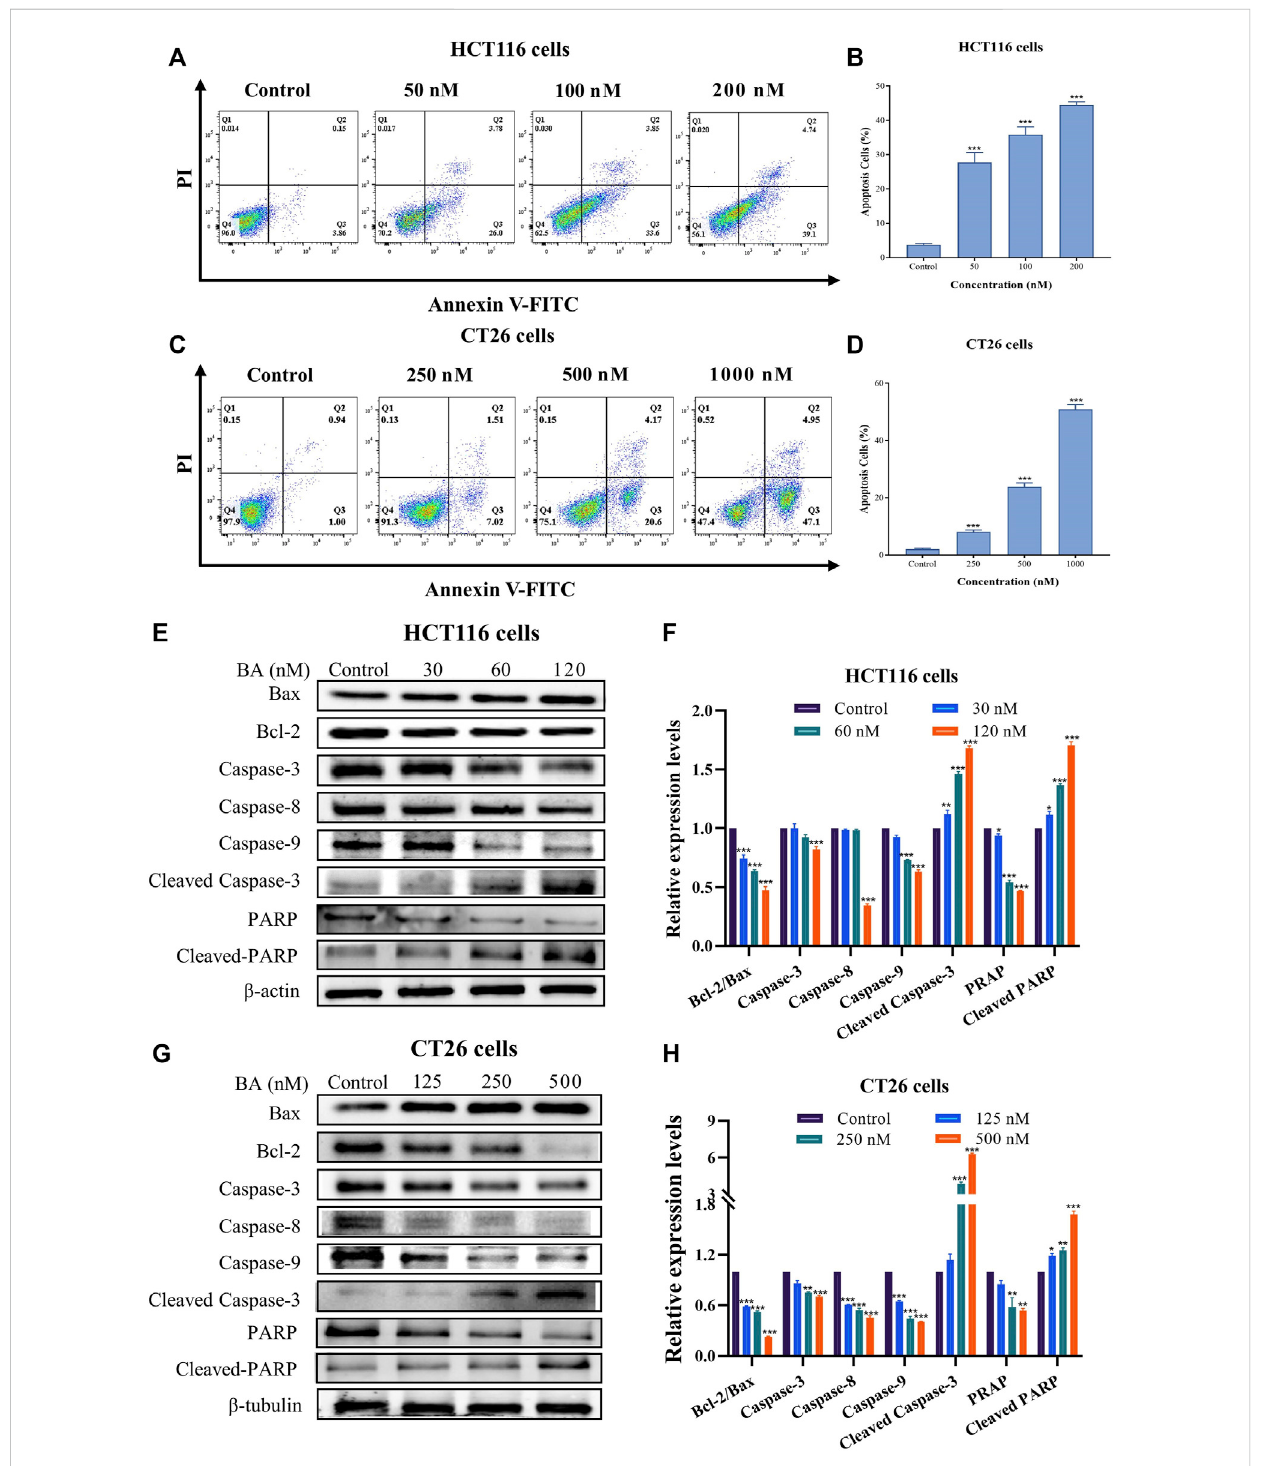
FIGURE 5 BA induced cell apoptosis in HCT116 and CT26 cells. (A – D) The level of apoptosis of HCT116 (A) and CT26 (C) cells treated with BA was assessed by Annexin V-FITC/PI double staining. Statistical analysis of the apoptosis rate of HCT116 (B) and CT26 (D) cells treated with BA. (E – H) The protein expression levelsofBax,Bcl-2, PARP,caspase-3/8/9,cleaved-RARPandcleaved-caspase-3 inBA-treatedHCT116 (E) andCT26 (G) cellsweremeasured by western blot, and β -actin or β -tubulin was served as a loading control. The relative protein levels of these proteins of HCT116 (F) and CT26 (H) cells were statistically analyzed, and the protein levels were normalized to the control group. ** p < 0.01, *** p < 0.001, compared to the control